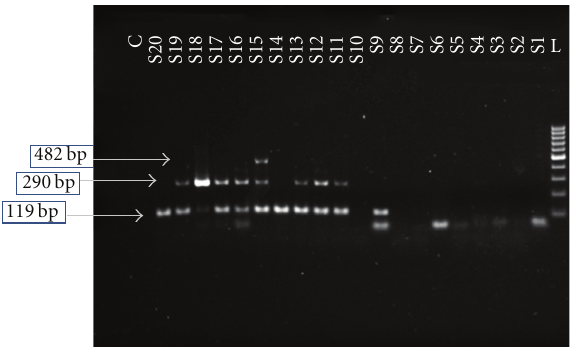
Figure 3: Results of dengue-specific RT-PCR followed by second- round nested PCR of RNA samples, showing band in 1.5% agarose gel electrophoresis stained with ethidium bromide. Lane L: 100 bp DNA ladder, Lane S1–S8 and S10: negative sample, Lane S9, S14 and S20: sample positive for DEN-2 (119bp), Lane S11–S13 and S16–S19: sample with dual infection of DEN-2 (119bp) and DEN- 3 (290bp), Lane S15: sample with concurrent infection of DEN- 1 (482 bp), DEN-2 (119 bp), and DEN-3 (290bp), and Lane C: negative